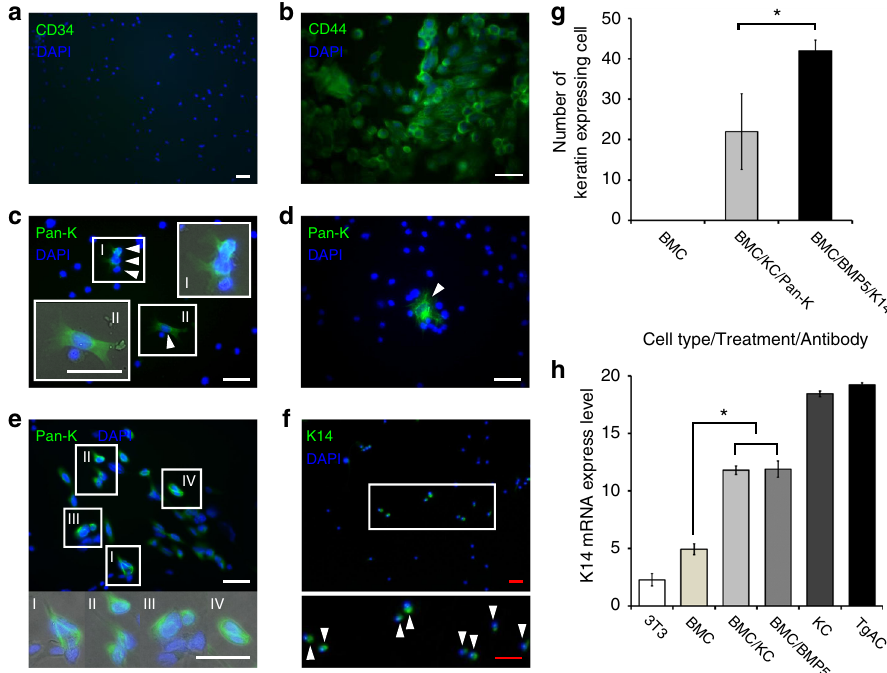
Fig. 1 CD34 − , CD44 + BMCs express keratin after BMC/KC co-culture and BMP5 treatment. a , b All adherent BMCs are CD34-negative and CD44- positive. c , e A sub set of adherent BMCs are pan-keratin-immunoreactive (arrowheads) after 7days of BMC/KC co-culture (keratin-positive BMCs in white boxes are magni fi ed and merged with phase image). d Pan-keratin-immunoreactive BMC (arrowhead) identi fi ed 10 days after BMP5 treatment. f K14-immunoreactive cells (arrowheads) 10 days after BMP5 treatment (white box area is magni fi ed). g Histogram of number of keratin-expressing BMCs; BMCs without treatment, BMC/KC co-culture (pan-keratin-positive BMCs, gray bar) and BMP5 treatment (K14-positive BMCs, black bar), pan- keratin- and K14-immunoreactive BMCs are detected in KC co-cultured and BMP5-treated BMCs, but no keratin-positive cells are detected in treatment controls ( n = 3, 3 different culture groups, 3 male and 3 female mice in each group; P < 0.017 as determined by Student ’ s t -test, mean ± s.d.) h Q-RT-PCR results show the relative level of K14 expression detected from positive (primary KCs and Tg.AC, a KC cancer cell-line) and negative (Swiss mouse 3T3 cell-line and primary BMCs) control groups, and experimental (BMC/KC co-culture and BMP5 treatment) groups. The expression levels were normalized to GAPDH expression levels, and expression mean values were converted into fold-change gene expression. Final values were normalized with log 2 transformation. ( n = 3, P < 4.81 × 10E − 12 as determined by Fisher ’ s ANOVA method, mean ± s.d.). *White scale bar, 50 µ m; Red scale bar, 200 µ